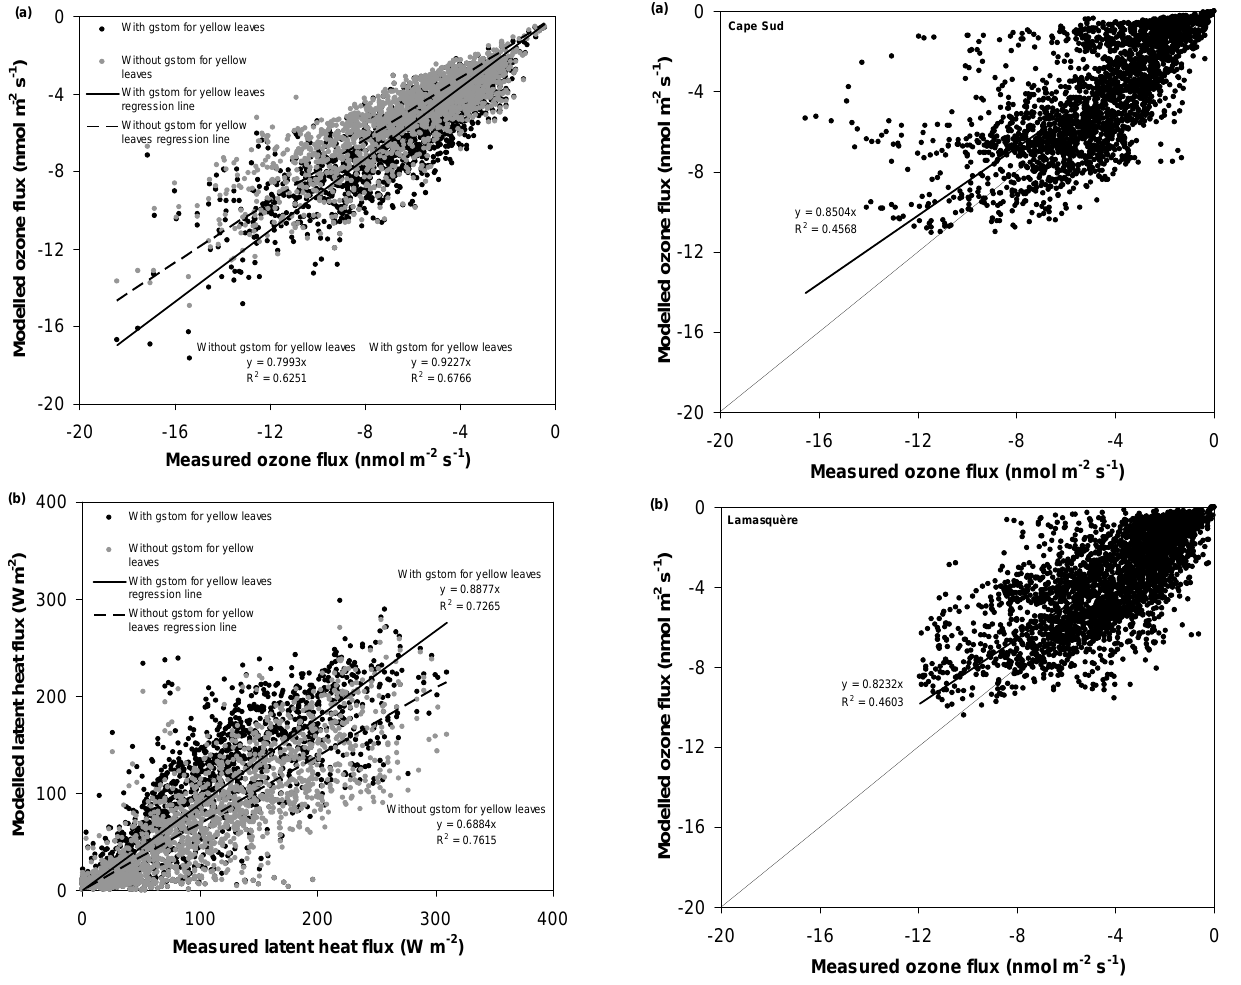
Figure 7: Comparison between measured and modelled ozone fluxes over the whole studying 30 Fig. 7. Comparison between measured and modelled ozone fluxes period for (a) La Cape Sud site and (b) Lamasquère site. Only data for u * > 0.1 m s -1 are 31 over the whole studying period for (a) La Cape Sud site and represented. 32 (b) Lamasqu`ere site. Only data for u ∗ > 0.1ms − 1 are represented. sites for any development stage (Figs. 8a, 9a and 10a).